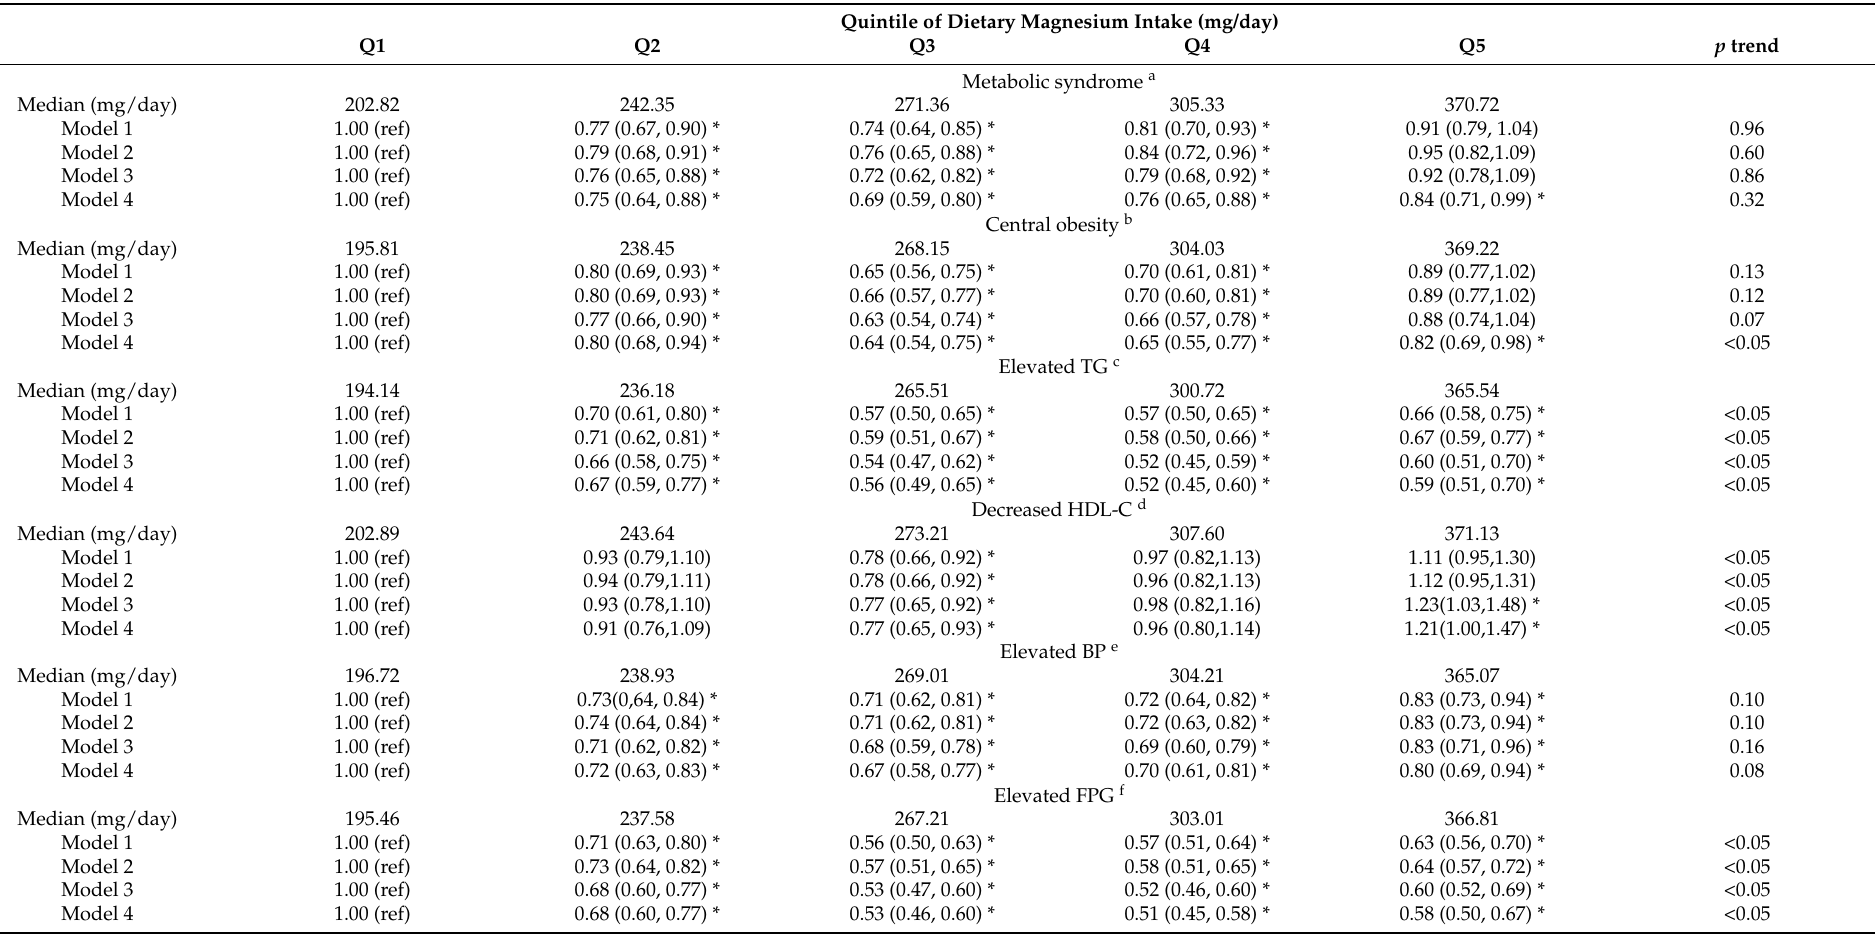
Table 2. Multivariate Cox proportional risk regression analysis of dietary magnesium intake to MetS and its components [HR (95%